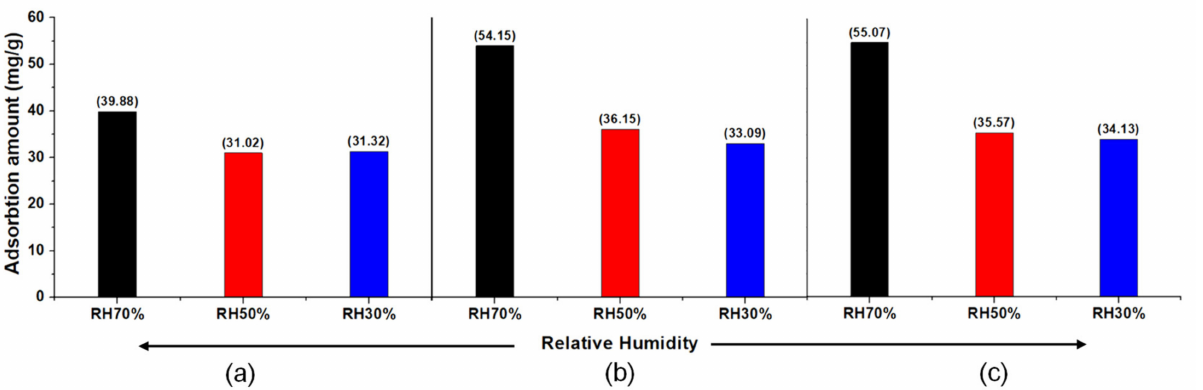
Figure 1. FA removal efficiency on the (modified) bead-type activated carbon at the various RH contents: ( a ) non-modified bead-type activated carbon, ( b ) halogen modified bead-type activated carbon, and ( c ) sulfur modified bead-type activated carbon. Operation conditions: 100 ppmv; space velocity: 40,000/h; temperature: